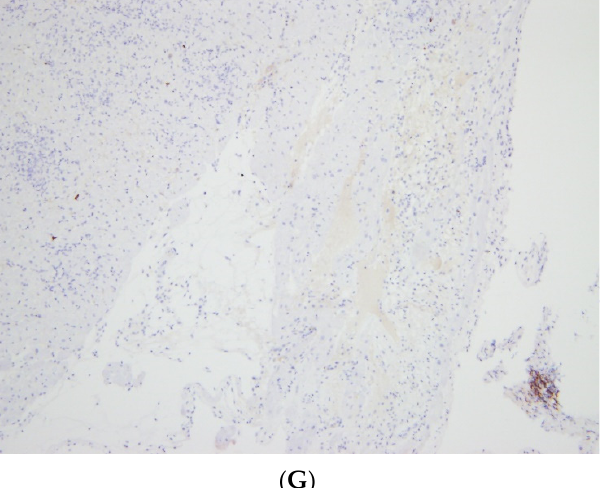
Figure 2. ( A ) Arrow 1—Dense infiltrate of inflammatory cells, mainly lymphocytes and neutrophils, with evidence of necrosis (on the left). Arrow 2—A region with edema but many more normal nuclei and without an infiltration of lymphocytes and neutrophils. ( B ) Enlarged image of Figure 1: Left: Significant infiltration of inflammatory cells with necrosis and loss of normal myocardial tissue. Right: Near normal tissue with mild edema. ( C ) CD163 staining for macrophages with a very intense and large area positive for macrophages. ( D ) CD3 staining of lymphocytes. ( E ) CD4 staining repre- senting a subpopulation of lymphocytes. ( F ) Staining for CD8 representing another subpopulation of lymphocytes. ( G ) Cells with CD20 staining demonstrating the near complete absence of B cells.